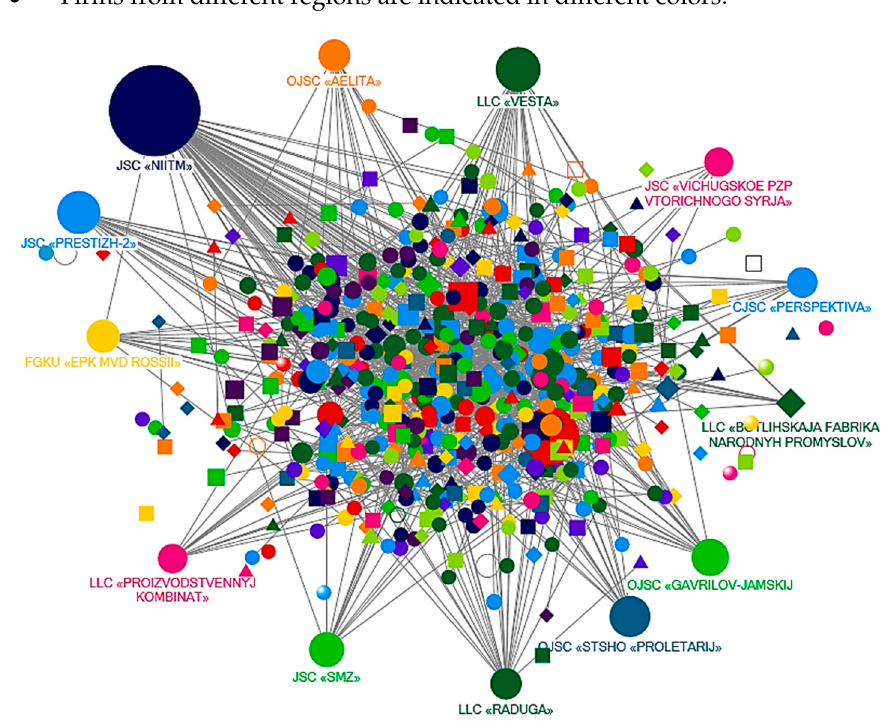
Figure 2. Network of firms in the Russian textile industry visualized in NodeXL.